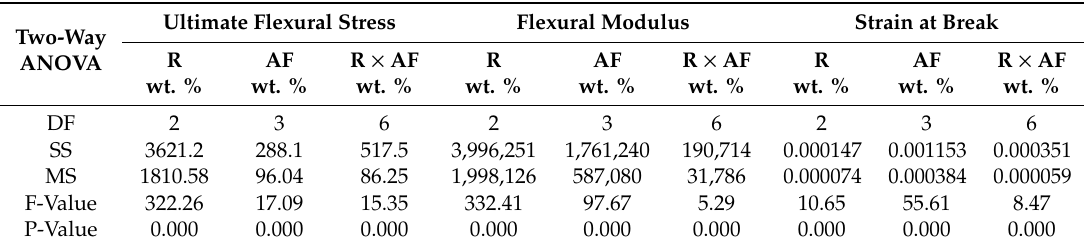
Table 4. Two-way ANOVA results on the mechanical properties of the